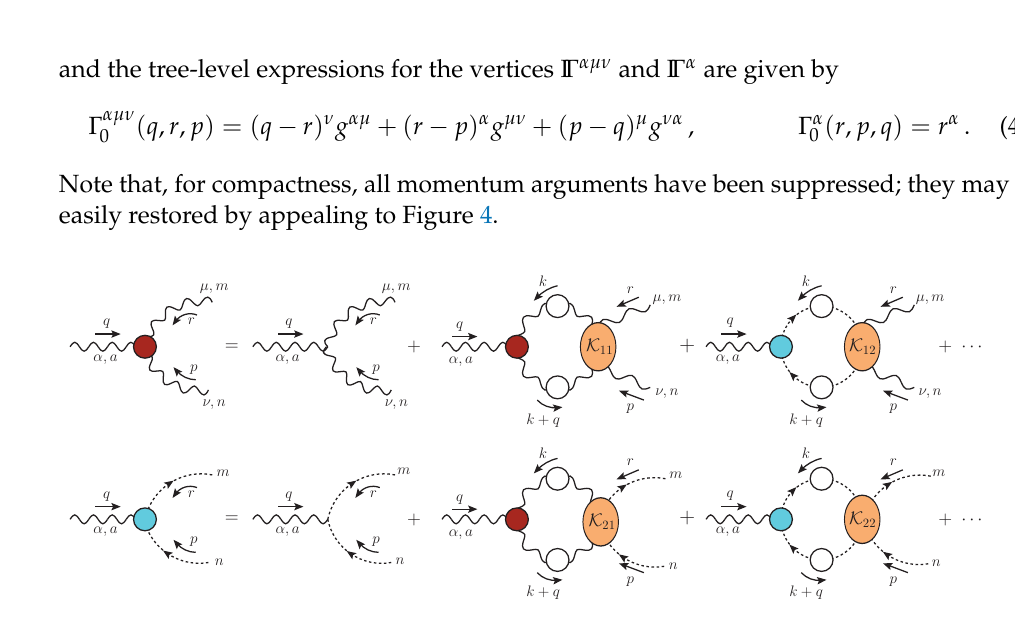
Figure 4. The coupled system of Schwinger–Dyson equations (SDEs) for the three-gluon and ghost– gluon vertices, I Γ αµν ( q , r , p ) and I Γ α ( r , p , q ) , respectively. The orange ellipses represent four-point scattering kernels, denoted by . We omit diagrams containing five-point scattering kernels. K ij